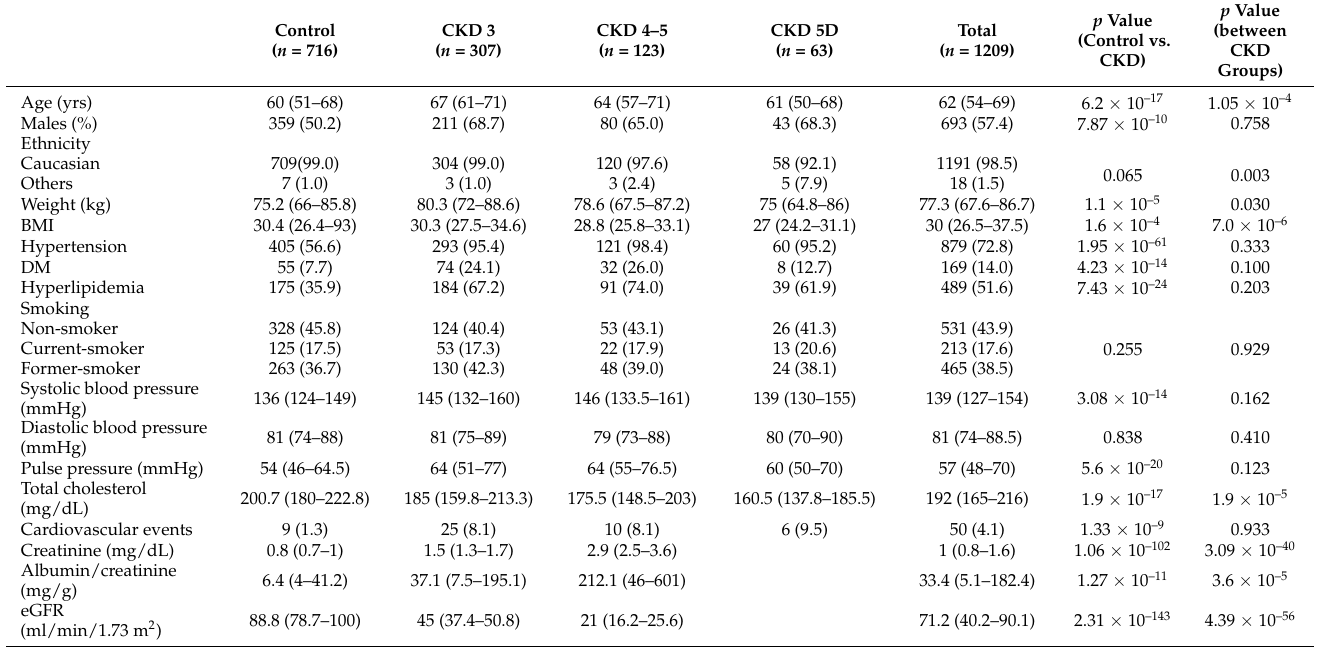
Table 1. Clinical and demographic characteristics of the population of study. Median (range) or count (percentages) are